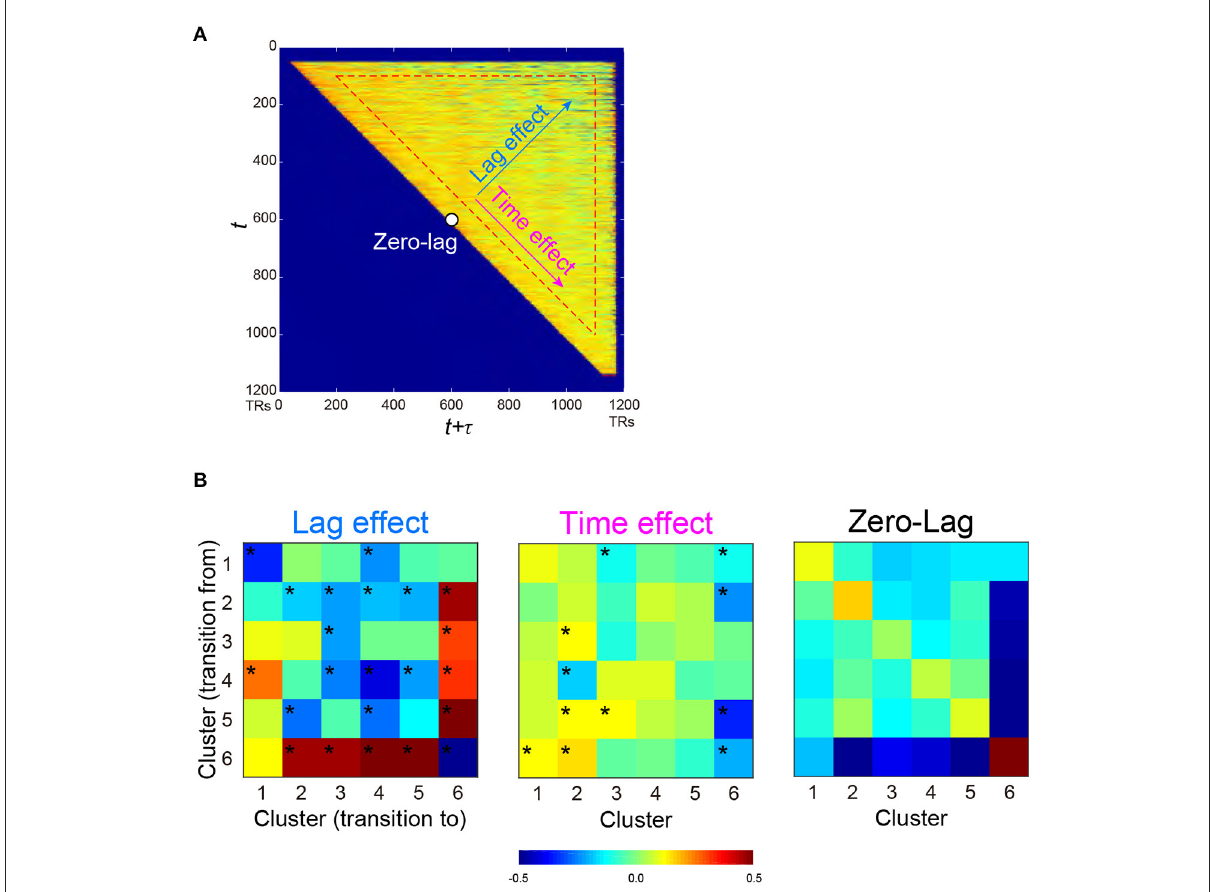
FIGURE4 PMI of occurrence probability reflects the temporal relationships of occurrences between two clusters. PMI was calculated at time t and t + τ , which provided a PMI matrix (A) . A PMI matrix was created for each combination of the 6 clusters, and each matrix was decomposed into lag ( τ ) effect, time ( t ) effect, and zero-lag (constant) effect based on multiple regression analysis. (B) Regression coefficients for all cluster combinations are color-coded for lag effect ( left ), time effect ( middle ), and zero-lag ( right ), as shown at the bottom. * P < 0.05, FWE-corrected for multiple